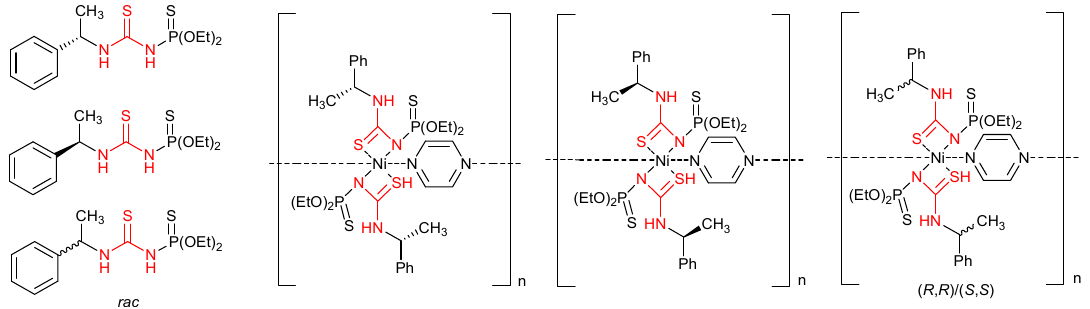
Figure 46. Structures of thiophosphorylated thioureas and their Ni(II) complexes forming coordination polymers studied for their antimicrobial activity [22].